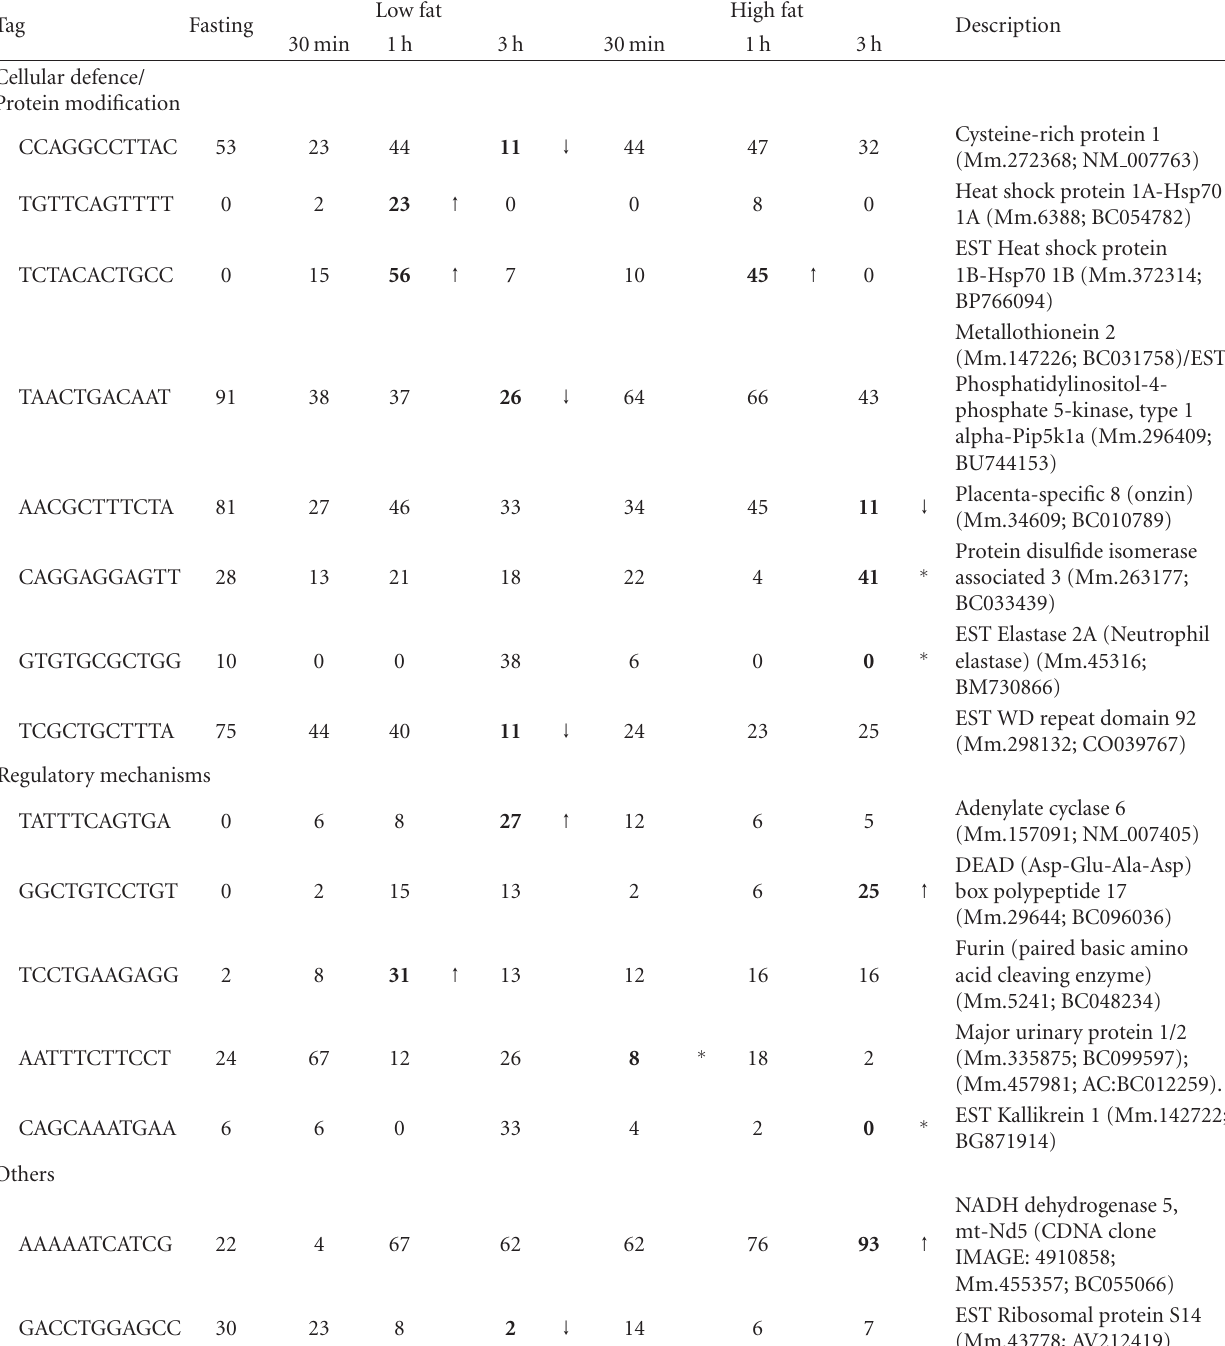
Table 2: Transcripts with defence/protection roles and other genes di ff erentially modulated by feeding in the gastric mucosa. Tag Fasting Cellular defence/ Protein modification